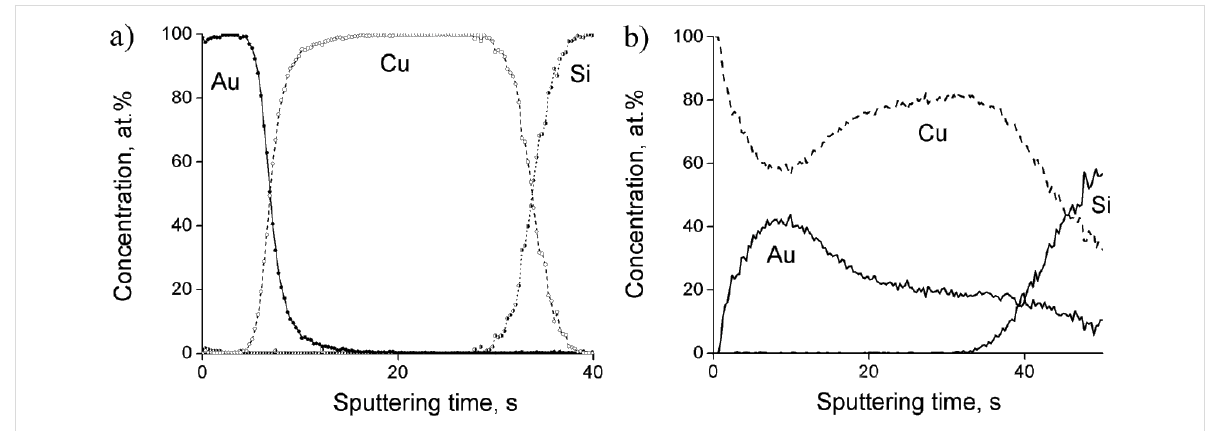
Figure 3: Concentration profiles of Au(10nm)/Cu(25nm) system a) as deposited and b) annealed at 180 °C for 5 h samples.